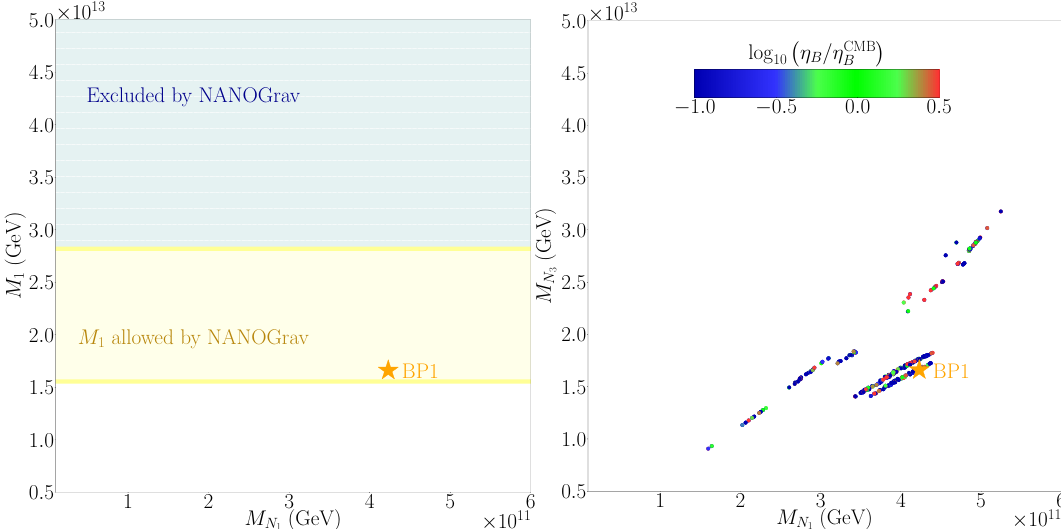
Figure 10 . Comparison between the results of our scan and NANOGrav12.5 bound. The yellow shaded region includes all the values of M consistent with NANOGrav. Applying the perturbativity 1 ansatz, i.e., M , we can see how most of the points in our scan are consistent with NANOGrav. 1 > M N 3 The first octant of lepton mixing angle θ is 23